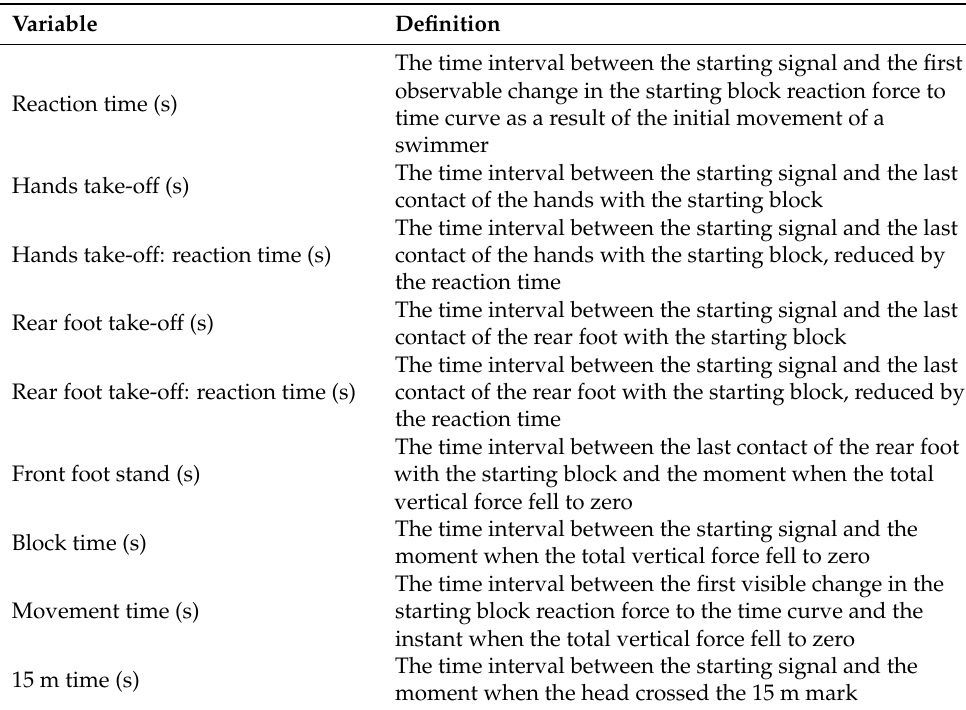
Table 1. Definitions of the variables used for the swimming start